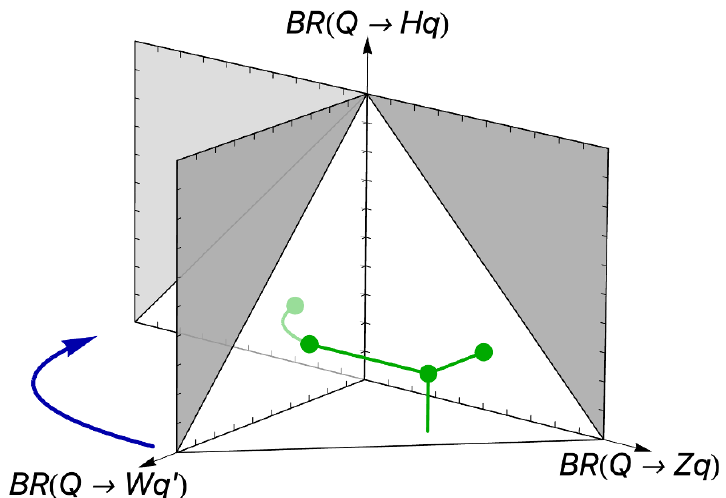
Figure 8 . Representation of the ( BR ( Q ! Zq ) ; BR ( Q ! W (cid:6) q 0 ) ; BR ( Q ! Hq )) point as its pro- jections into the BR ( Q ! Zq ){ BR ( Q ! Hq ) plane and into the BR ( Q ! W (cid:6) q 0 ){ BR ( Q ! Hq ) plane.